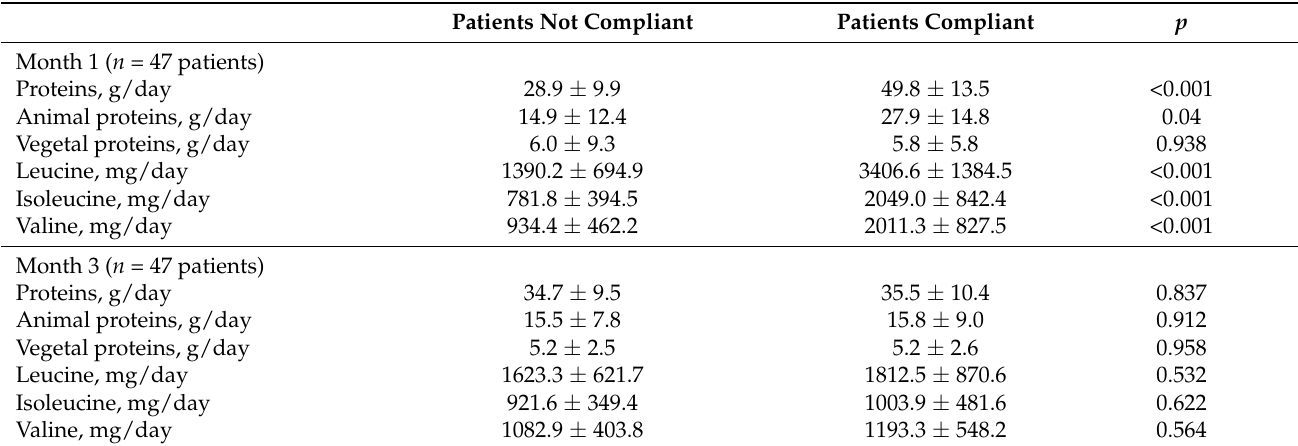
Table 4. Comparison between overall protein intake in patients who have or have not actually taken protein supplementation at 1 month and 3 months after